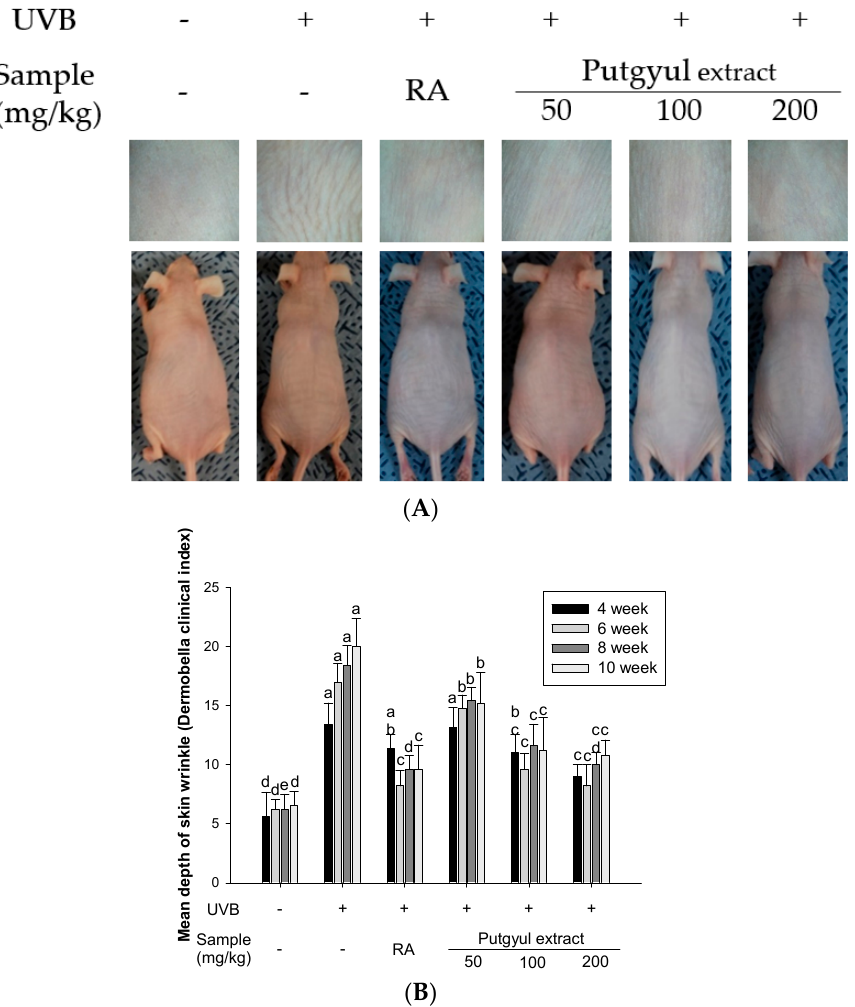
Figure 3. Effect of putgyul extracts on UVB-induced wrinkle formation in hairless mice. ( A ) Features of dorsal skin of hairless mice exposed to UVB; ( B ) Mean of skin wrinkle depth. a–d All values are presented as means ± SD. Bars with different letters indicate statistically significant differences among the groups at p < 0.05 by one-way ANOVA.